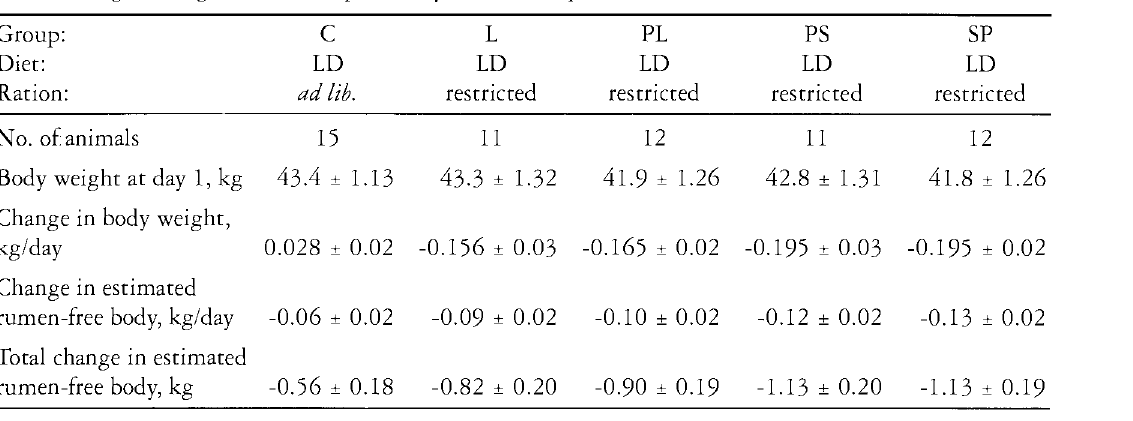
Table 3- Number of reindeer, body weight at the start of the restriction period (day 1) and calculated changes in body weight during the restriction period, days 1-9 (least-square mean ± standard error). LD = lichen-based diet.